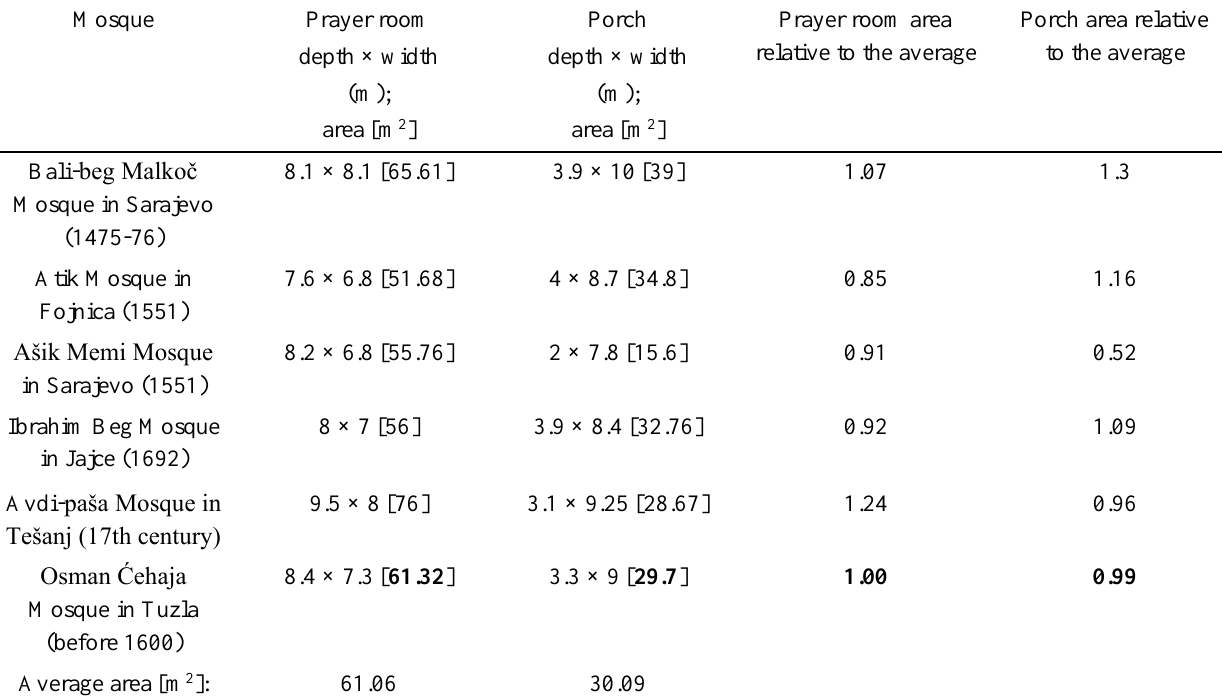
Table 1. Comparison of characteristic examples of mosques with a single-story wooden